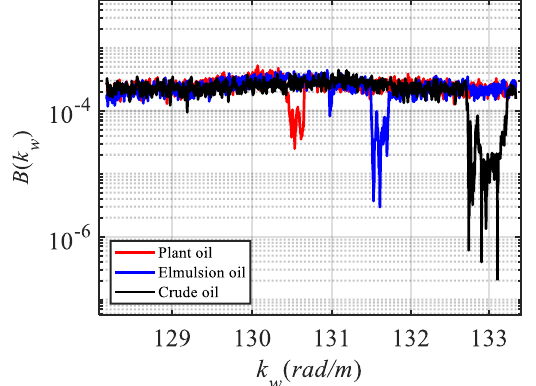
Figure 8. The “pure” Bragg wave curvature spectrum inverted from the three white lines in Figure 6.